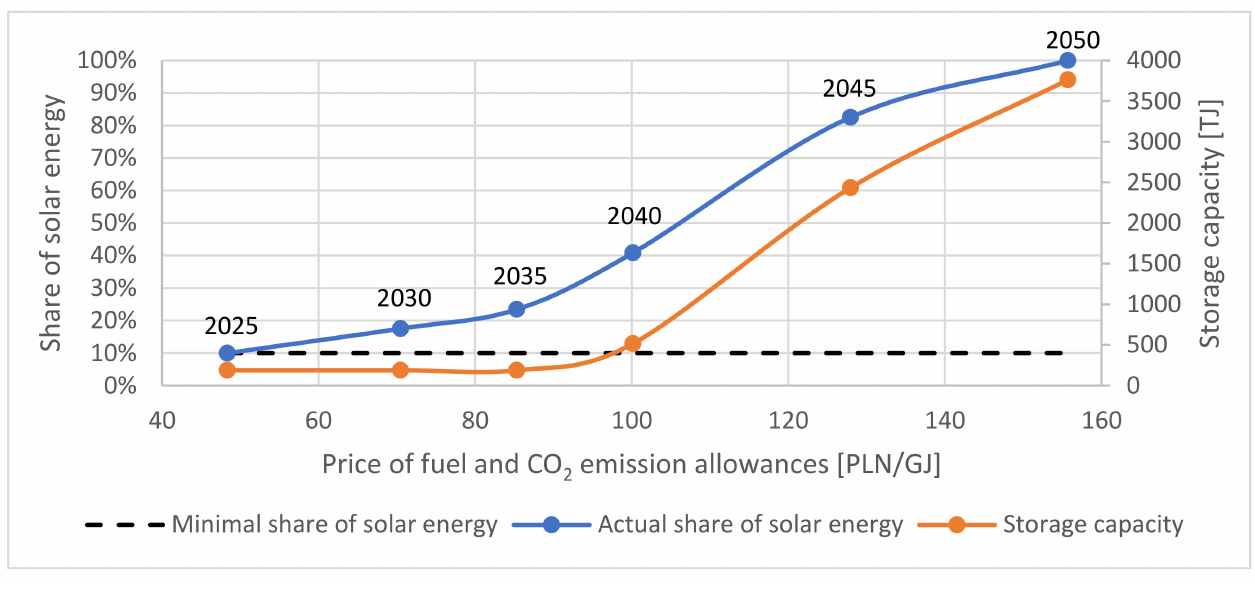
Figure 9. Share of heat from solar collectors and heat storage capacity as a function of the purchase cost of fuel and CO 2 emission allowances by a gas heating plant in DYN